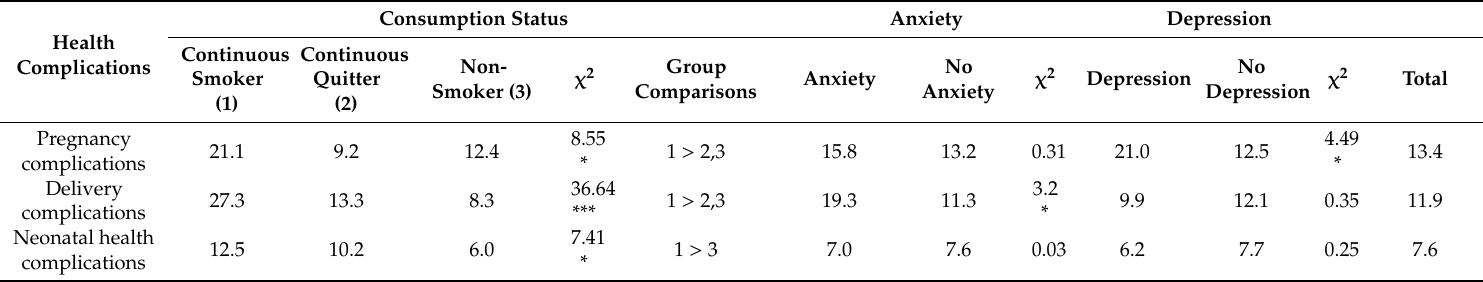
Table 2. Association between consumption status, anxiety or depression, and health